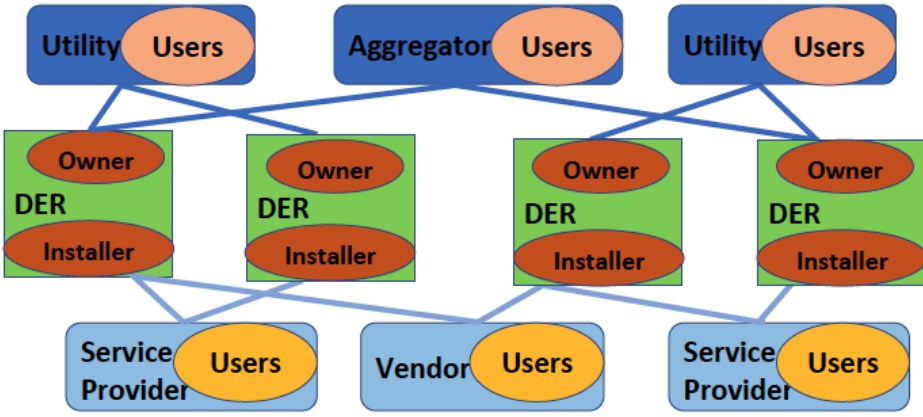
Figure 1. DER Ecosystem Topology.